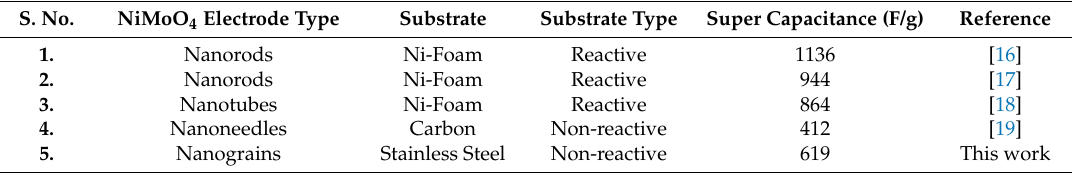
Table 1. Data of previous NiMoO 4 nanostructure-based reports compared with our work . S. No. S.